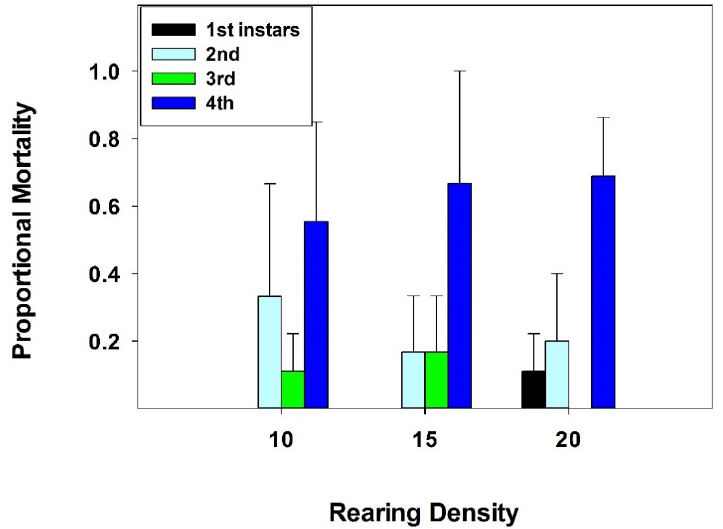
Figure 1. Mean ± SE proportion of dead 1st–4th instar larvae in 10, 15, and 20 density treatments in replicate trials. A total of 33 dead larvae were observed.